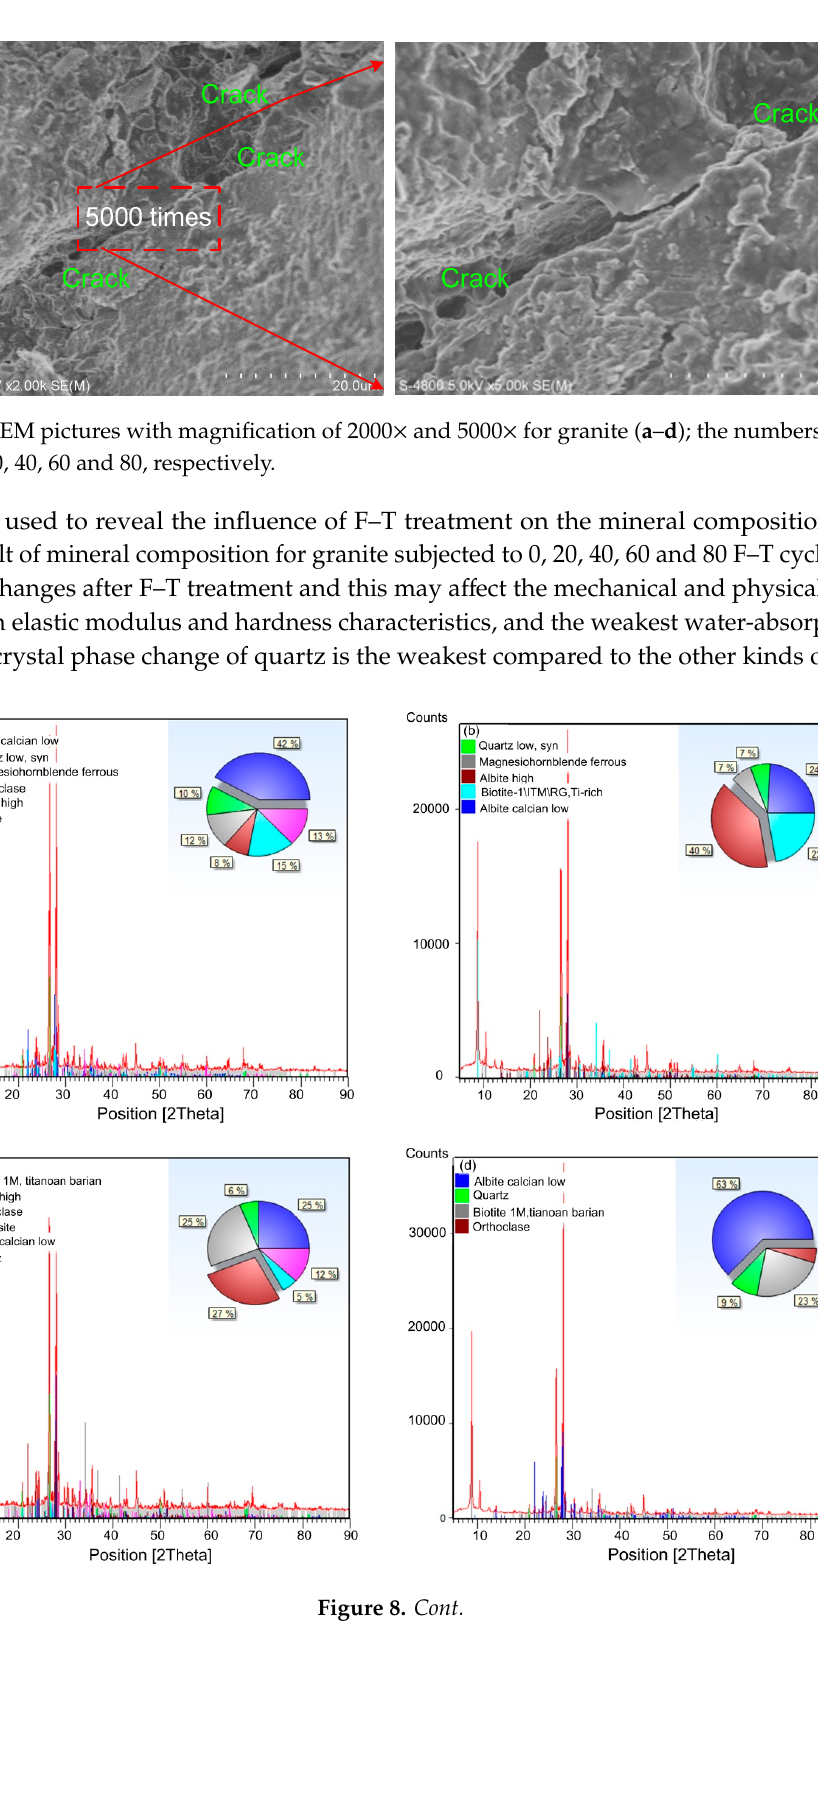
9 Figure 8. XRD results ( a – e ); the numbers of F–T cycles are 0, 20, 40, 60 and 80, respectively; ( f ) the main mineral content changes at different F–T cycles. 3.2. Strength and Stress–Strain Responses With the increase of F–T damage and further expansion of micro-cracks induced by frost’s heaving stress, the internal rock structure suffers from deterioration, and this would affect the strength and deformation characteristics. Figure 9 shows the strength and the complete stress strain